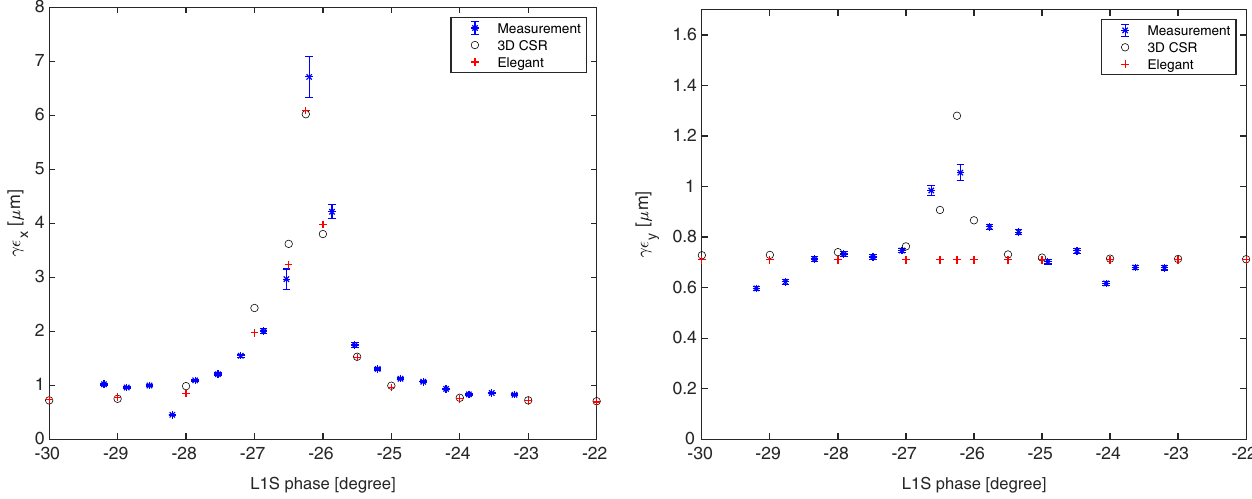
FIG. 10. A comparison of the measurements and simulations of the horizontal (on left) and vertical (on right) emittance for the first bunch compressor in the